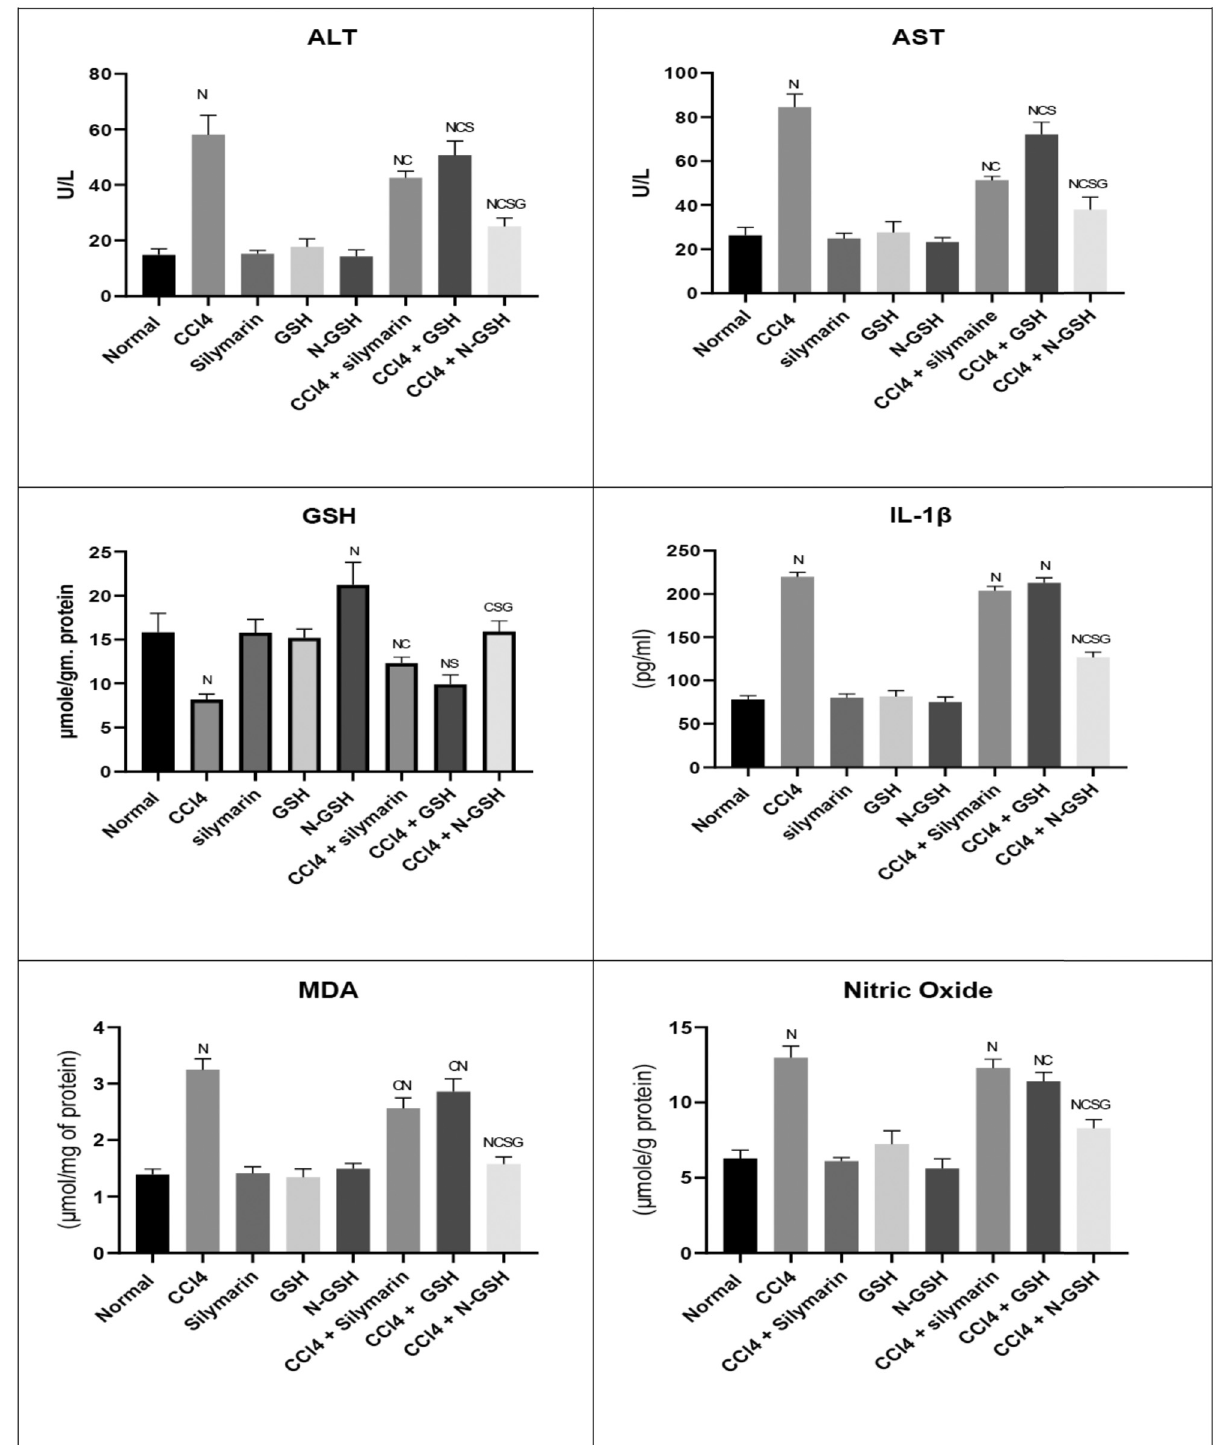
Figure 4: Variations in the levels of biochemical parameters in the normal, injured, and treated rats. ( N = signi fi cantly di ff erent compared to the normal group, C = signi fi cantly di ff erent compared to the CCl 4 group, S = signi fi cantly di ff erent compared to the CCl 4 + silymarin group, G = signi fi cantly di ff erent compared to the CCl 4 + glutathione group )